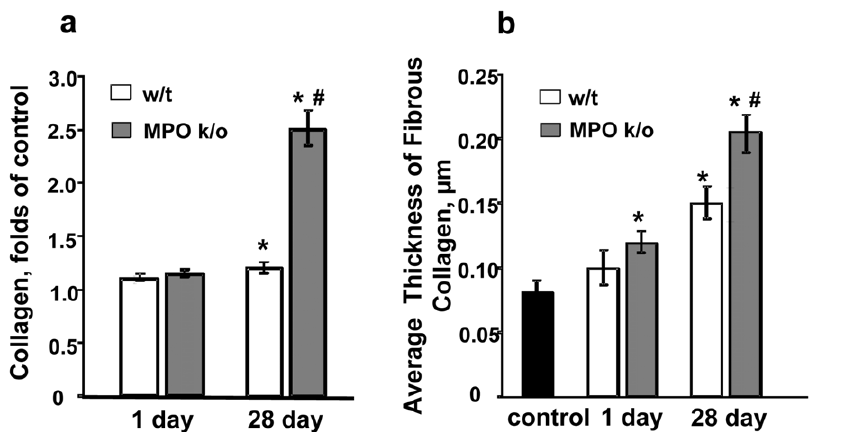
Figure 2. Changes in the content of collagen and average thickness of alveolar connective tissue in the lungs of w/t and MPO k/o mice at days 1 and 28 after pharyngeal aspiration of SWCNT. a. Accumulation of collagen in the lung of w/t or MPO k/o mice. Mean 6 SEM (n=6 mice/group). *p , 0.05, vs control PBS-exposed mice, # p , 0.05, vs w/t mice 28 days post exposure. b. Morphometric assessments of average thickness of alveolar connective tissue in the lung of w/t or MPO k/o mice. Mean 6 SEM (n=6 mice/group). *p , 0.05, vs control PBS-exposed mice, # p , 0.05, vs w/t 28 days post exposure.